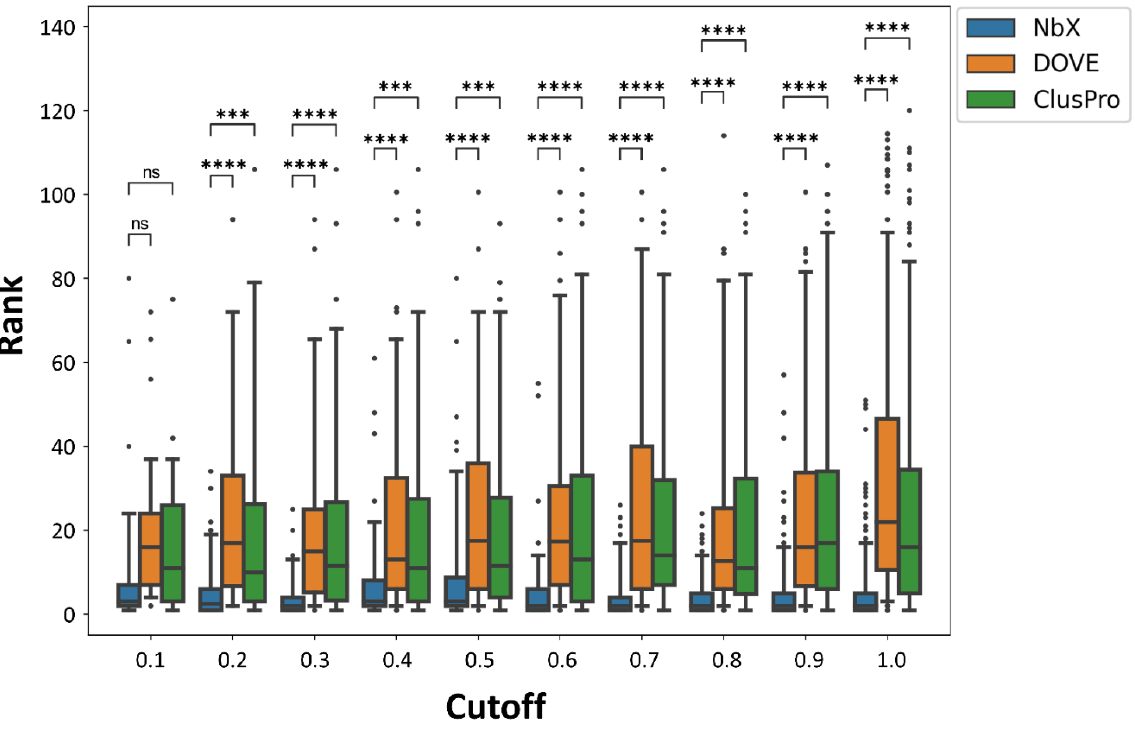
Figure 2. Re-ranking performance of NbX in different cutoffs of pairwise structural alignment quality score. Whole populations of ranking of the native-like nanobody pose from the 5-fold cross-validated test sets were plotted. Annotations for p value in t -Test are as follow, ns: 0.05 < p ≤ 1.00; ***: 0.0001 < p ≤ 0.001; **** p ≤